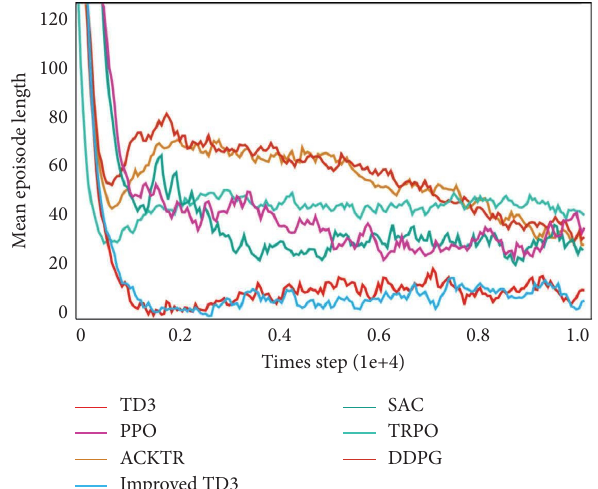
Figure 8: Comparison of robustness using seven diferent DRL